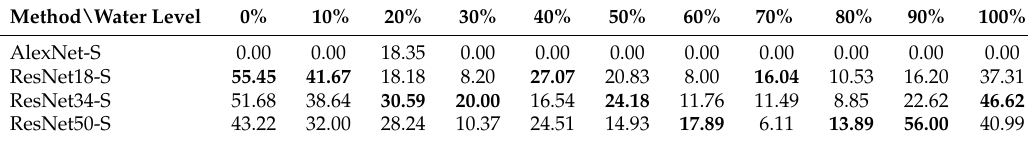
Table A2. Per-class F1 score for the CNNs trained from scratch—Class10 training setting. Method\Water Level